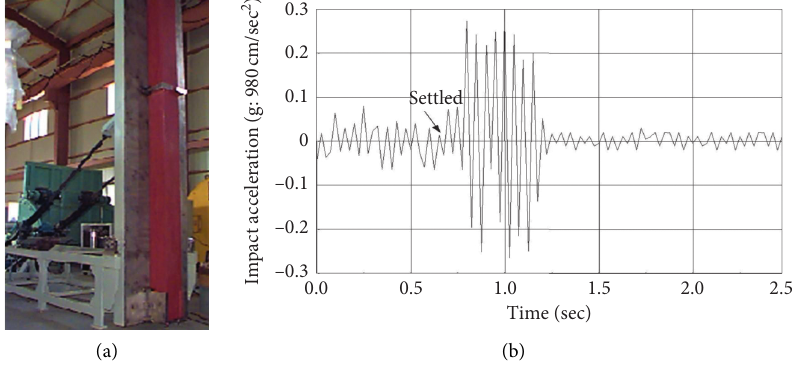
Figure 6: Impact of assembly on table: (a) test setup and (b) impact